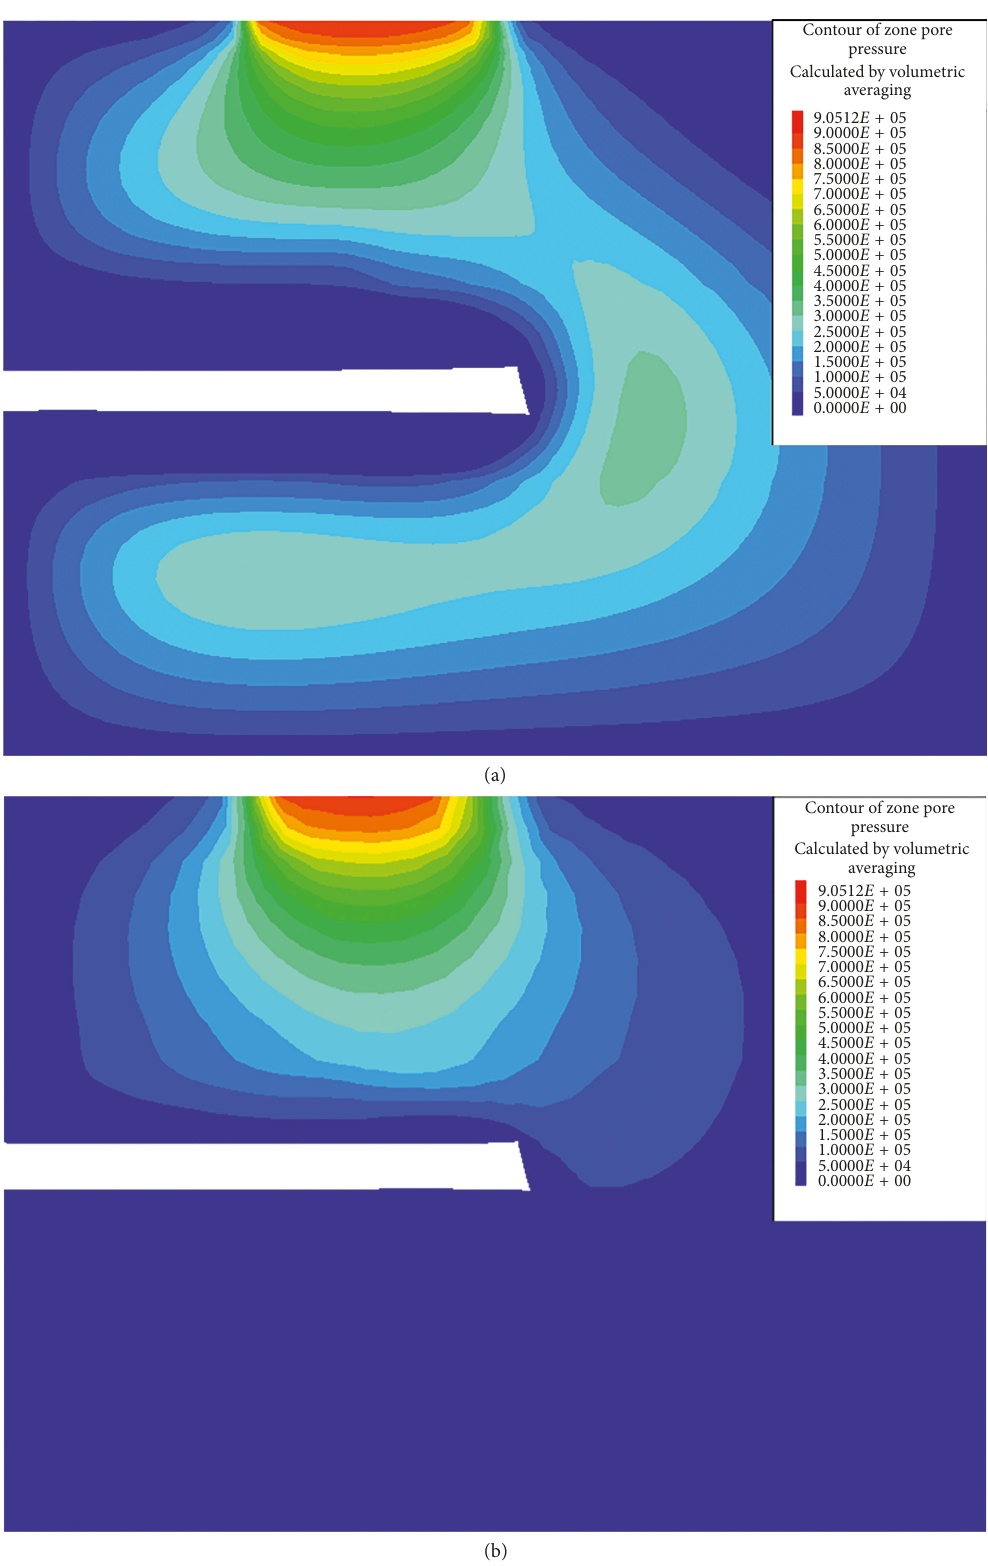
Figure 6: Pore-water pressure distribution in fault fracture zone under different supporting conditions. (a) Shed supporting condition and (b) bolt-grouting supporting